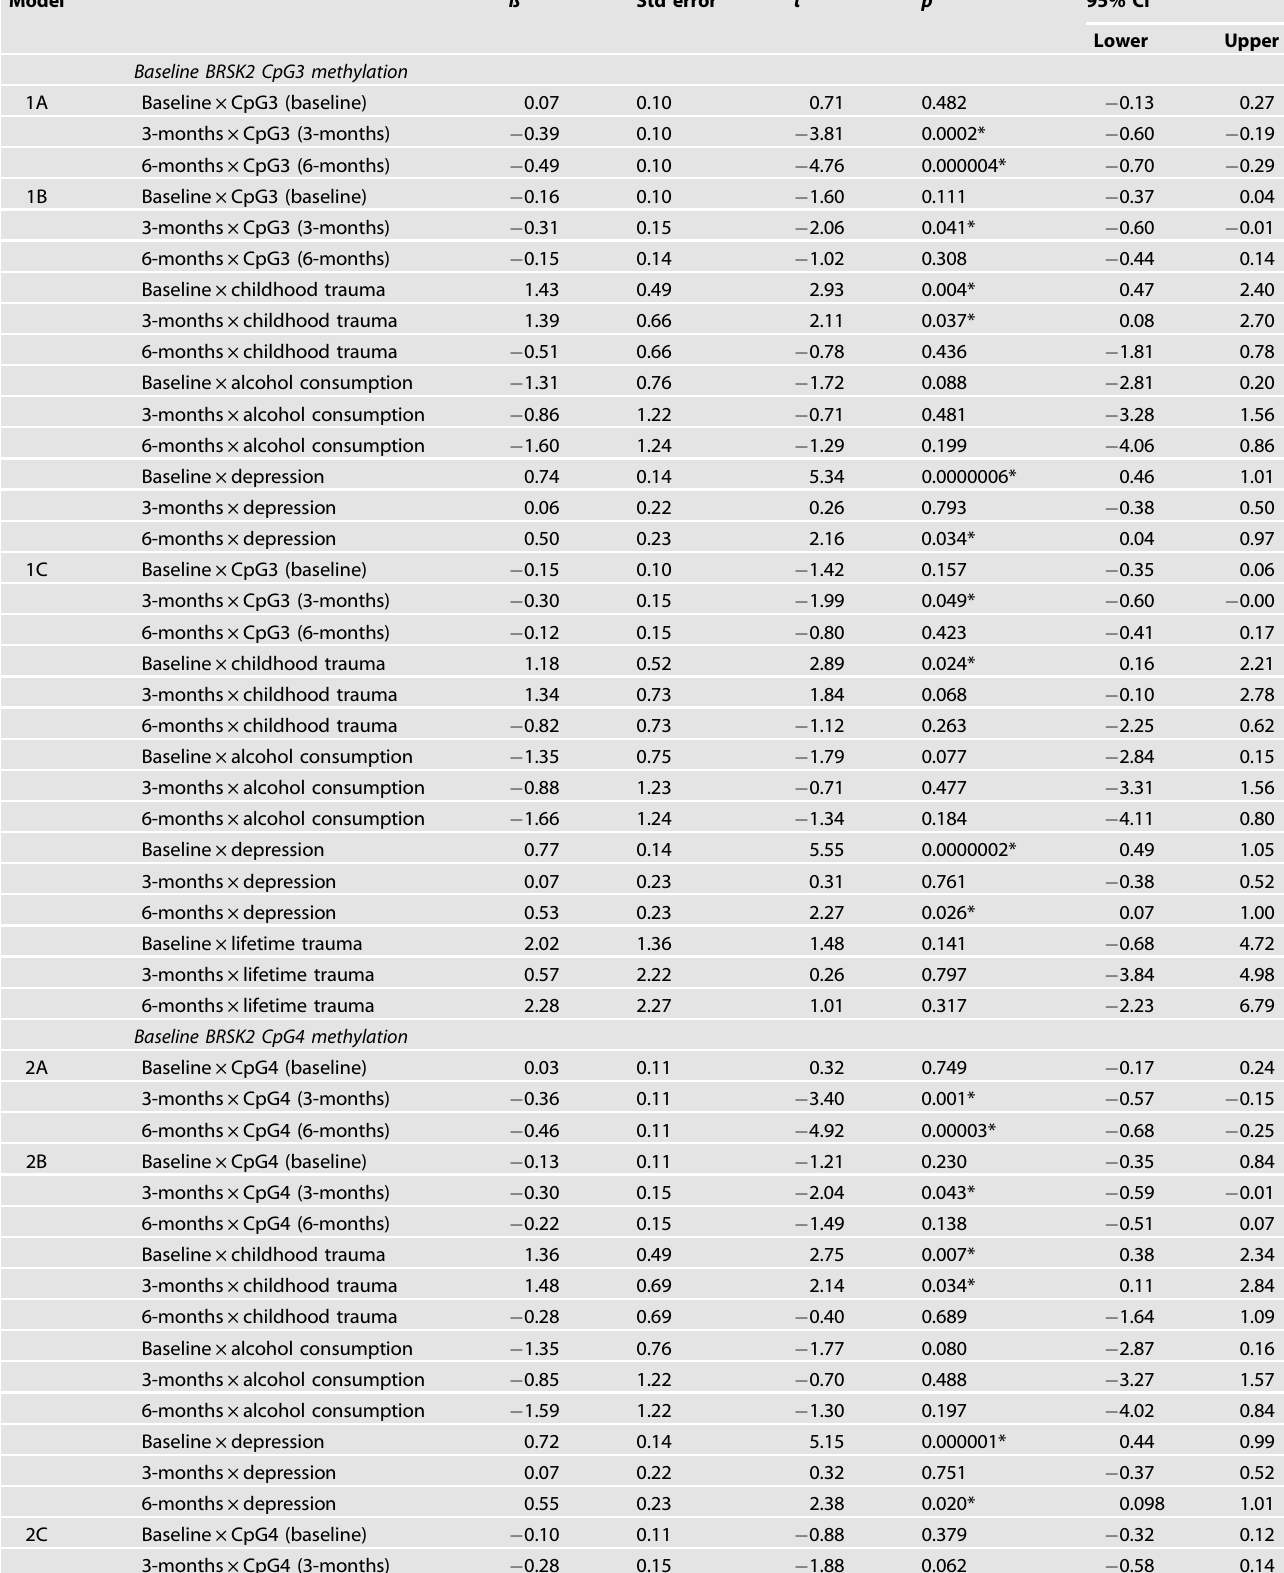
Table 6. Summary statistics of the mixed regression models investigating change in BRSK2 and ADCYAP1 methylation over time as predictors of change in posttraumatic stress symptoms scores over time.